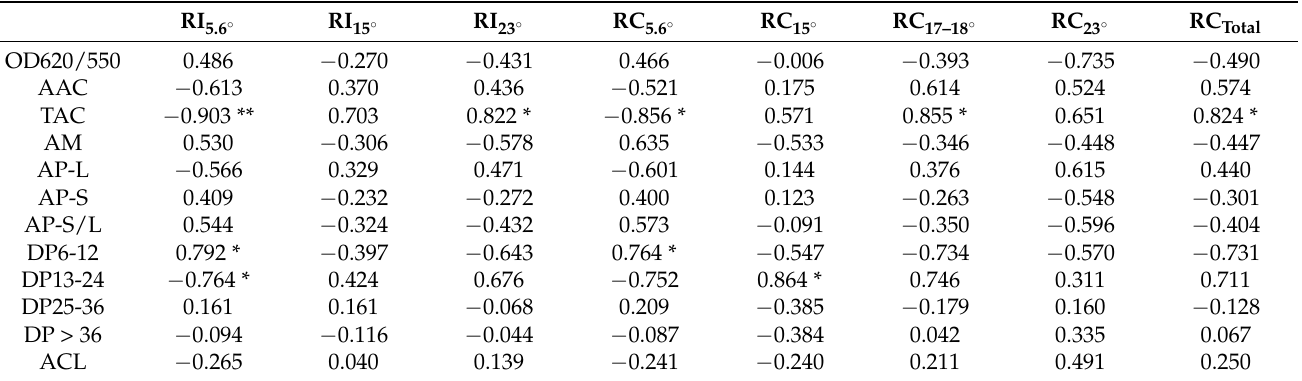
Table 4. Pearson correlation coefficients between intensities/crystallinities of X-ray diffraction peaks and molecular components of C-type